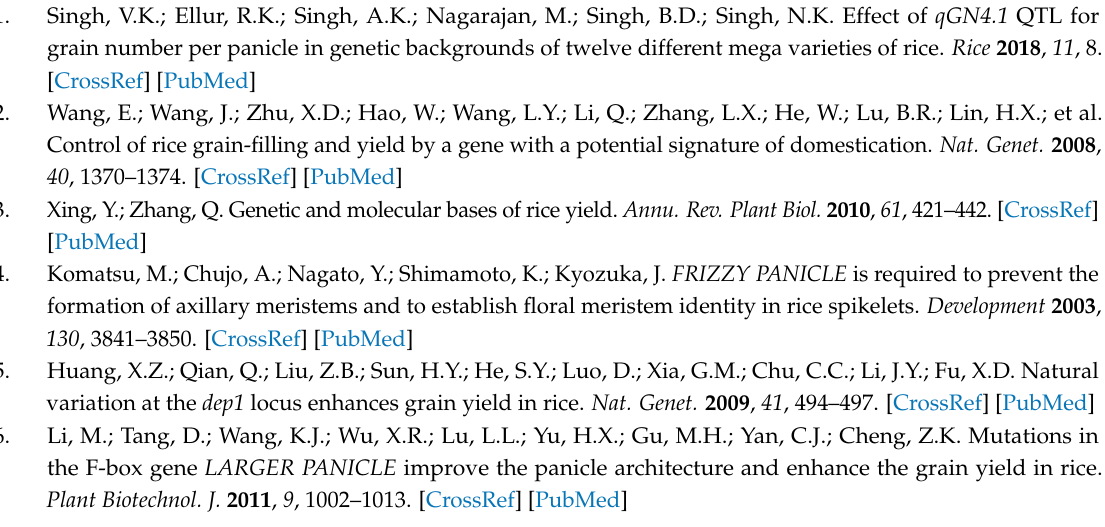
Figure S1: Analysis of internode pattern and lamina joints of WT and ltbsg1 , Figure S2: The detection of pollen vitality between WT and ltbsg1 , Figure S3: Phylogenetic tree of LTBSG1 with 20 homologous proteins in different plants, Figure S4: The confirmation of mutation sites of LTBSG1 three knock-out lines by sequencing, Table S1: Primer list of this study, Table S2: Predicated function analysis of candidate genes of ltbsg1 , Table S3: Agronomic traits of Nipponbare (Nip) and three knock-out lines, Table S4: Gene ontology enrichment analysis for part of differentially expressed genes involved in biological